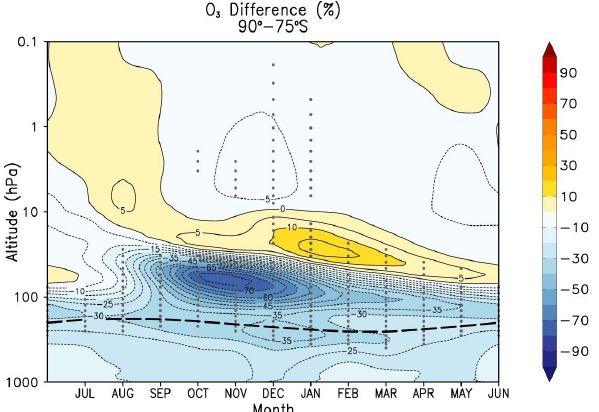
Figure 2: Zonal mean, monthly mean total column ozone REF2000 climatology (contours) Figure 2. Zonal mean, monthly mean total column ozone REF2000 Figure 1. Zonal mean, monthly mean percentage ozone difference Figure 1: Zonal mean, monthly mean percentage ozone difference between REF2000 and climatology (contours) and difference between REF2000 and NHC and difference between REF2000 and NHC (shaded). Contour intervals are 25 DU, stippling between REF2000 and NHC, averaged over 90–75 ◦ S. Contour in- NHC, averaged over 90°-75°S. Contour intervals are 5%, solid/dashed contours represent (shaded). Contour intervals are 25DU; stippling denotes signifi- denotes significance at the 95% confidence level. tervals are 5%; solid/dashed contours represent positive/negative cance at the 95% confidence positive/negative changes. Stippling denotes significance at the 95% confidence level. The changes. Stippling denotes significance at the 95% confidence bold dashed line signifies the tropopause height in the REF2000 simulation. level. The bold dashed line signifies the tropopause height in the REF2000 simulation using a two-tailed Student’s t test.